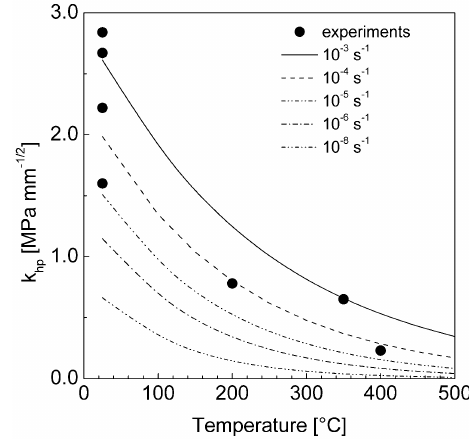
Figure A1. Experimental values of the Hall-Petch constant (from [42] and [43]) and model curves for different strain rates.